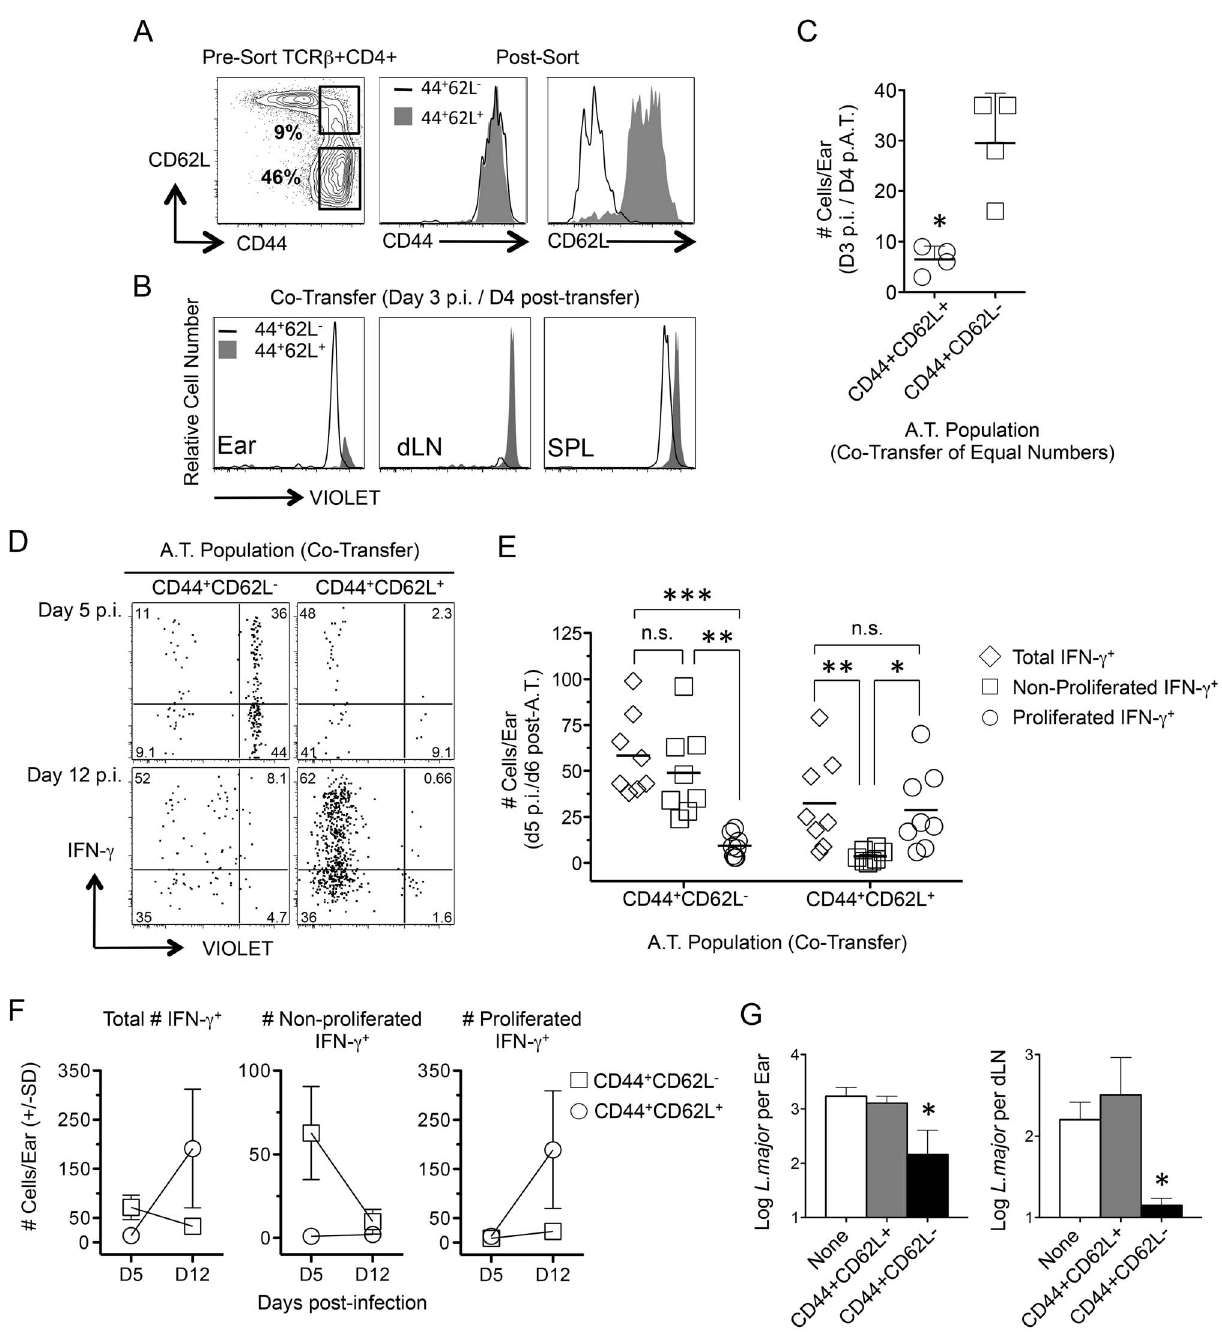
Figure 4. Rapidly recruited antigen-specific cells confer protection and are not derived from central memory cells stimulated by challenge. ( A–F ) CD4 + CD44 + CD62L + (T CM ) and CD4 + CD44 + CD62L 2 T cells were FACS sorted from chronic congenic mice, labeled with VIOLET proliferation dye and co-transferred into naı¨ve UB-gfp mice (see Fig. S2). One day post-transfer recipient mice were challenged with L.m . Ears or purified CD4 + T cells from the spleen or dLNs of recipient mice were analyzed at the indicated time-points post-challenge by flow cytometry (histograms and dot-plots gated on TCR b + CD4 + donor cells). ( A ) Representative FACS plots of CD44 and CD62L expression on CD4 + T cells from chronic mice pre- and post-sorting. ( B and C ) Recipient mice were co-transferred with equivalent numbers (3 6 10 6 ) of T CM and CD4 + CD44 + CD62L 2 T cells. Recipient mice were analyzed on day 3 post-challenge. *, p=0.028. ( D–F ) Sorted cells were co-transferred at their physiological pre-transfer ratio (1–1.5 6 10 6 T CM ; 3–4 6 10 6 CD4 + CD44 + CD62L 2 ). At the indicated times post-infection cells from recipient mice were subjected to short-term (8 hours) Ag re-stimulation. ( D ) Representative dot-plots of IFN- c production and dilution of VIOLET proliferation dye from a single-mouse. Numbers in dot plots represent frequencies. ( E ) Pooled analysis of the proliferation history of transferred, IFN- c + , cells on day 5 p.i. Data is pooled from three independent experiments. ***, p=0.005; **, p , 0.008; *, p=0.012. ( F ) Total number of transferred cells per ear over time. Data is pooled from three independent experiments. ( G ) Sorted cells were independently transferred into naı¨ve recipient mice at their physiological ratio. Three weeks post challenge with 500 L.m. metacyclic promastigotes the ears and dLN were analyzed for parasite burden by limiting dilution analysis. *, p=0.022 (ears) or p=0.028 (dLN) versus the naı¨ve group. Data is representative of two or more independent experiments.